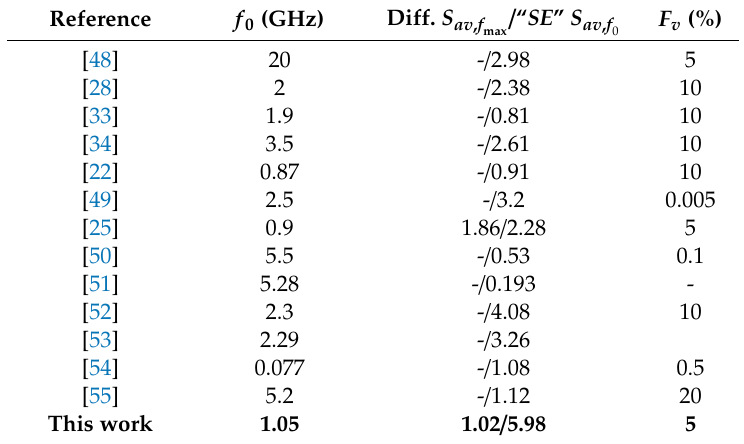
Table 2. Comparison of various microwave fluidic sensors for dielectric characterization.